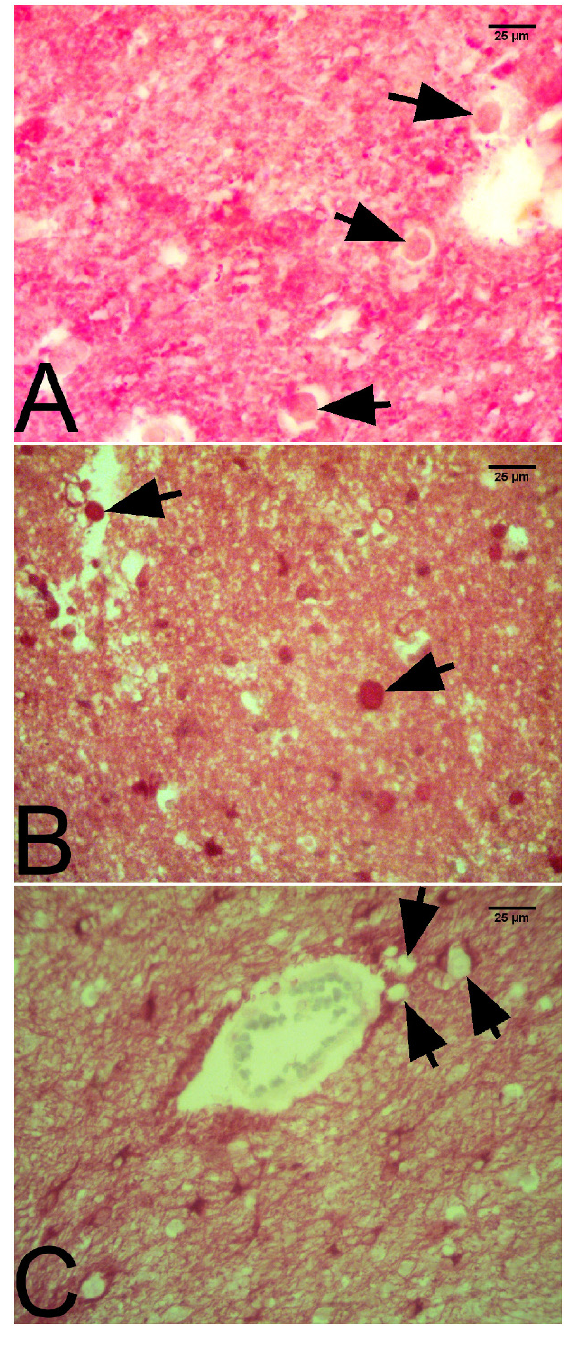
Figure 2. (A) A 57-year-old male case with NSE-positive subcorti- cal CA (arrows) (B) A 70-year-old male case with S100 positive subcortical CA (arrows) (C) A 58-year-old female case with GFAP-negative CA (arrows); APAAP; 40x lens